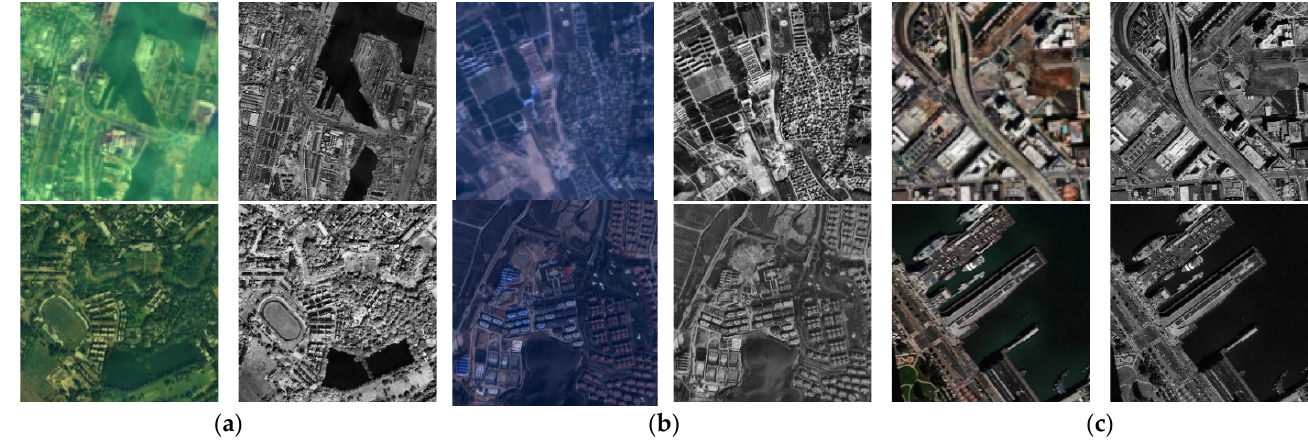
Figure 6. The MS and PAN images used for experiments. ( a ) QuickBird, ( b ) GaoFen-2, ( c ) WorldView-2. In the three datasets, the top left are the MS images of the simulated experiment, the top right is the PAN image of the simulated experiment, the bottom left are the MS images of the real experiment, and the bottom right is the PAN image of the real experiment.